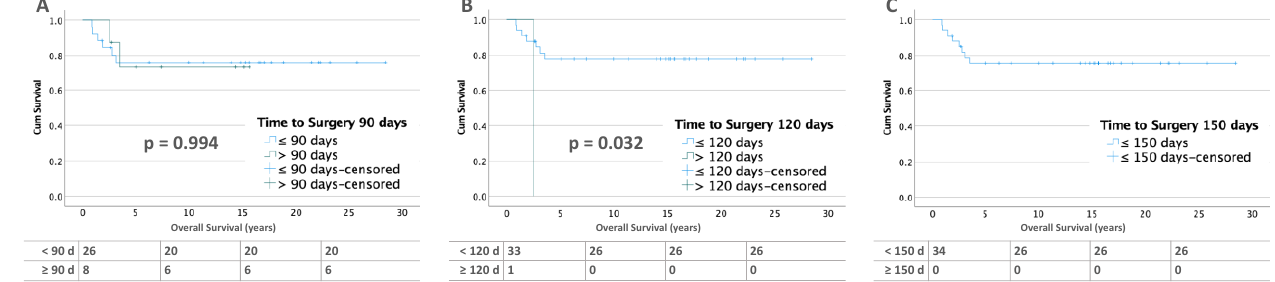
Figure 9. Kaplan – Meier lifetables of OS of bilateral WT with metastases at diagnosis at thresholds of 90 ( A ), 120 ( B ), and 150 ( C ) days of preoperative chemotherapy. No patient underwent surgery after 150 days, so lifetable C shows only the <150-days group. In the tables below the figures, the numbers at risk are reported.